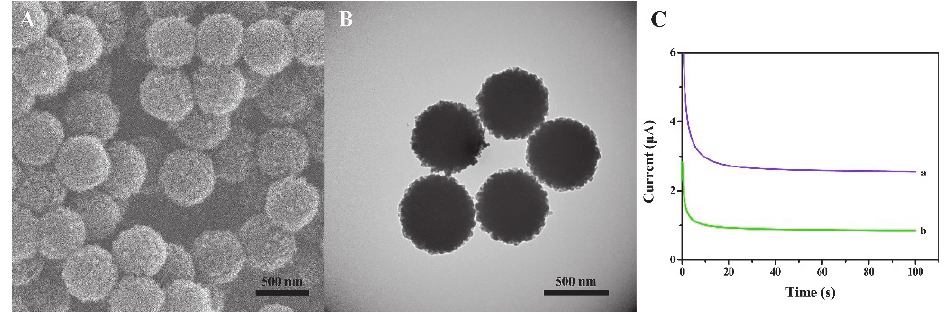
Figure 2. SEM( A ) and TEM ( B ) images of COFs. ( C ) The current response of (a) Histostar@ COFs and (b) HRP ‐ IgG.